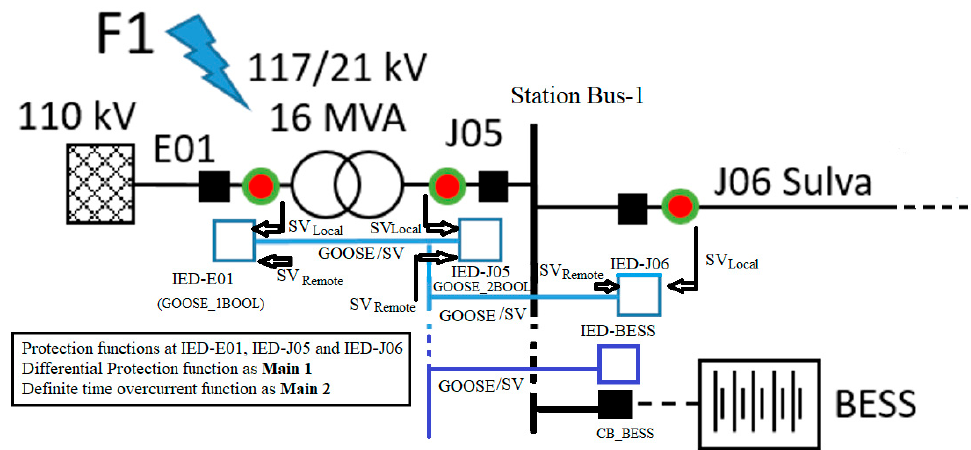
Figure 18. Single line diagram of the overcurrent fault F1 at the transformer terminal TUC (based on Figure 8).